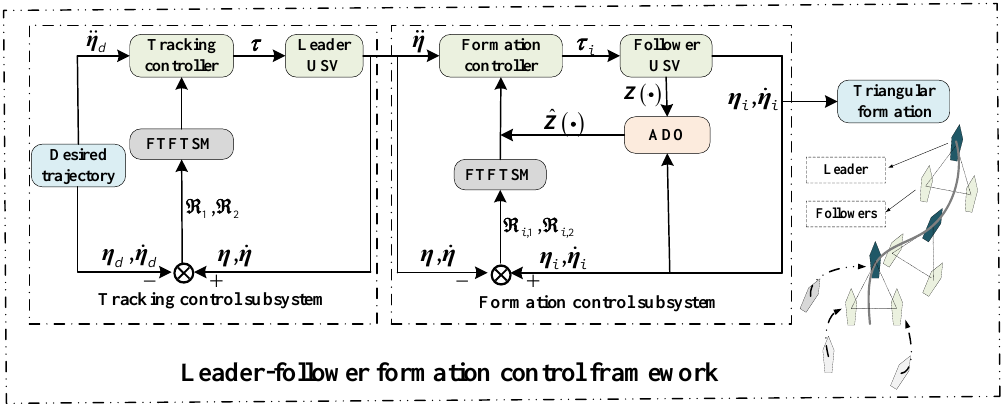
Figure 2. The algorithm architecture of the integrated USV formation